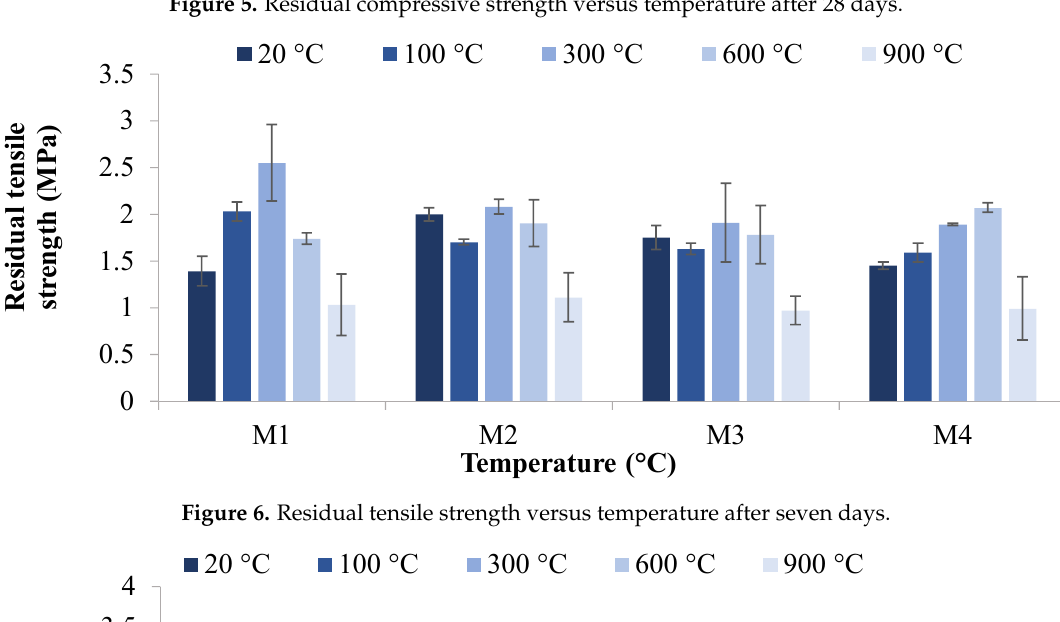
Figure 5. Residual compressive strength versus temperature after 28 days.